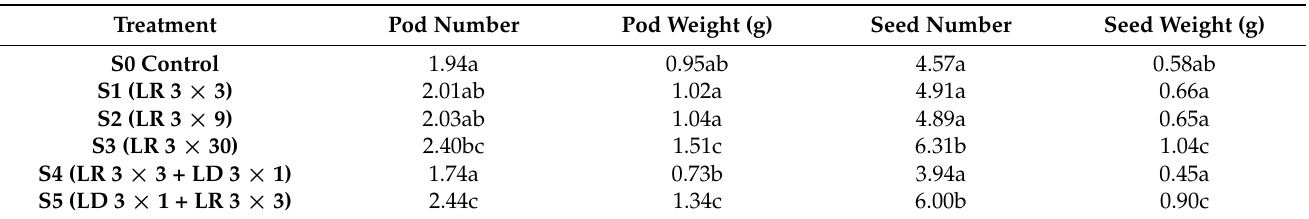
Table 7. Elements of yield structure for lateral branches of plants grown from control and laser- stimulated